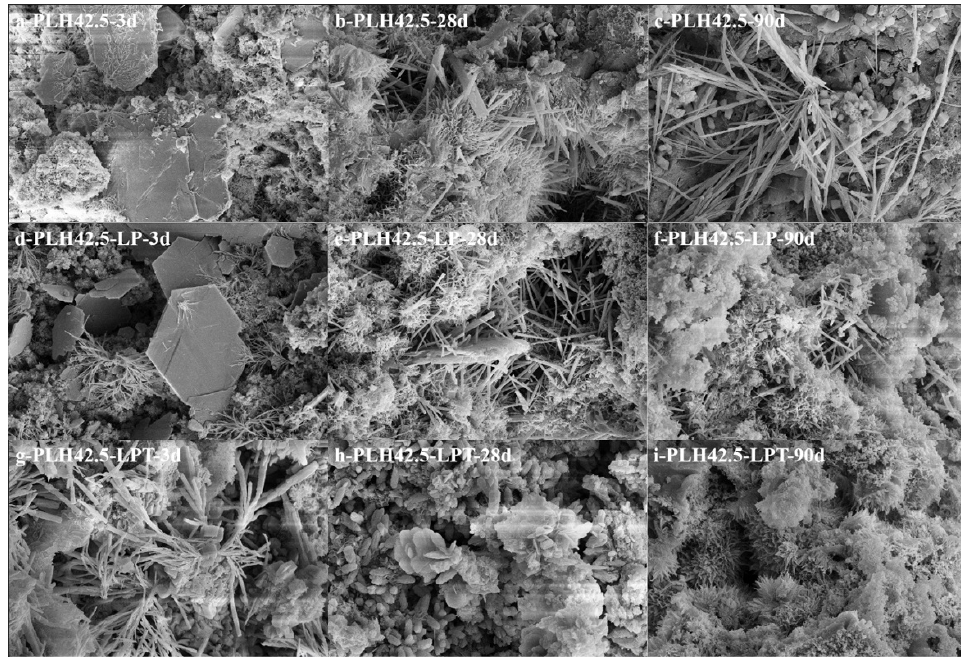
Figure 7. SEM image of PLH42.5 ( a – c ), PLH42.5-LP ( d – f ), PLH42.5-LPT ( g – i ) curing for 3 days, 28 days, and 90 days.